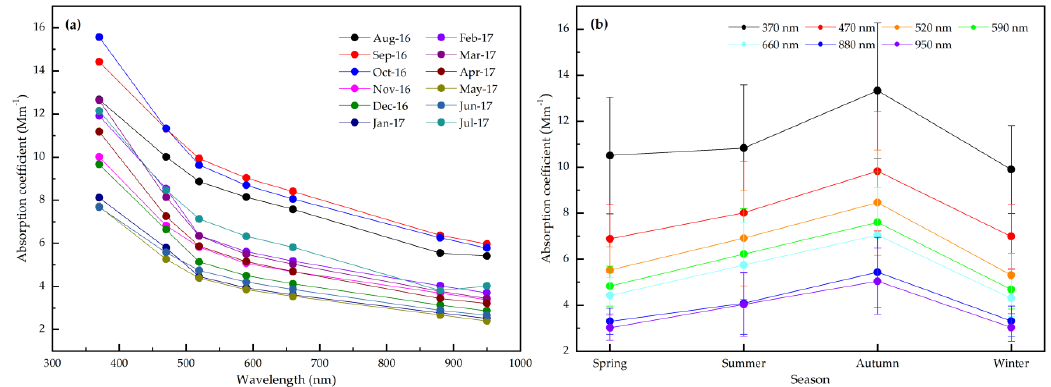
Figure 5. The spectral ( a ) and seasonal ( b ) mean of the absorption coefficients.